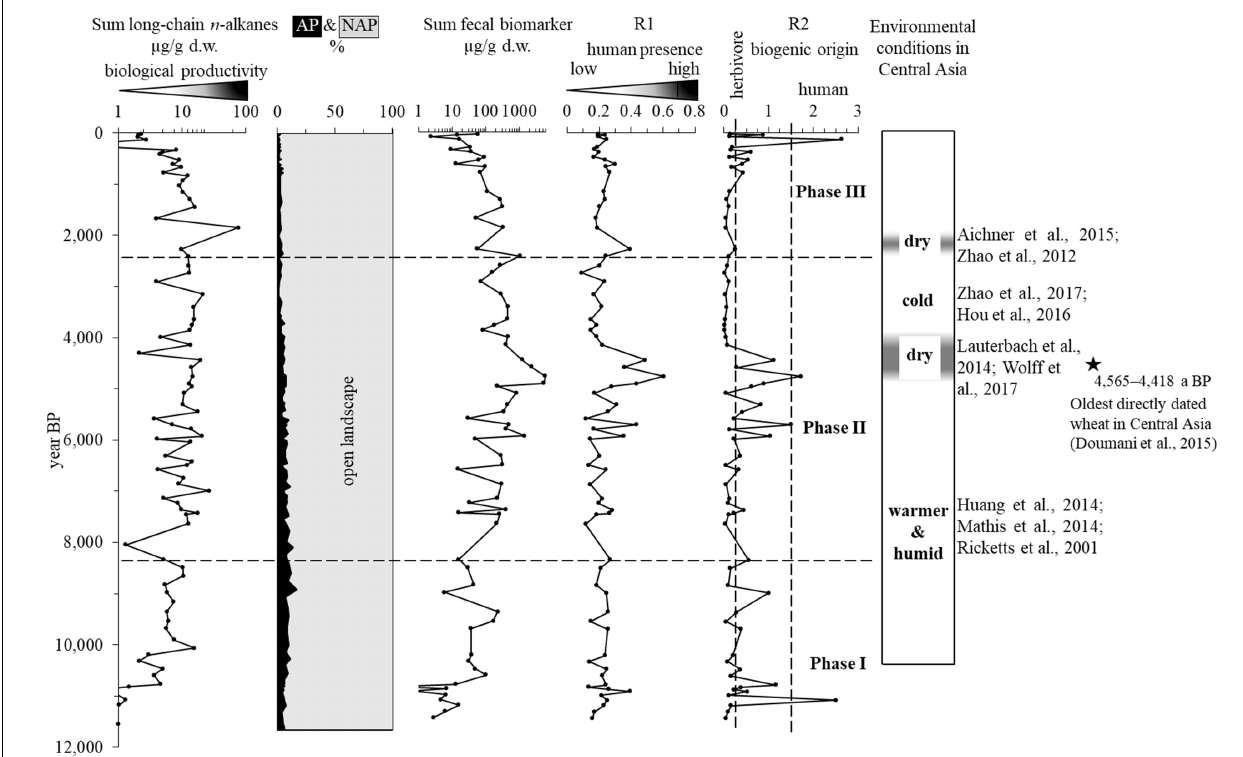
FIGURE 3 | Profiles of the sum of long-chain n-alkanes ( n C 27 + n C 29 + n C 31 ), pollen percentages of arboreal pollen (AP, black area) and non-arboreal pollen (NAP, gray area) with AP + NAP = 100%, sum of fecal biomarkers, R1 (coprostanol + epicoprostanol)/(coprostanol + epicoprostanol + 5 α –cholestanol), R2 (coprostanol/5 β – stigmastanol) and environmental conditions during the Holocene. Time periods of increased human presence at ∼ 4,800 and ∼ 2,500 a BP seem to coincide with dry